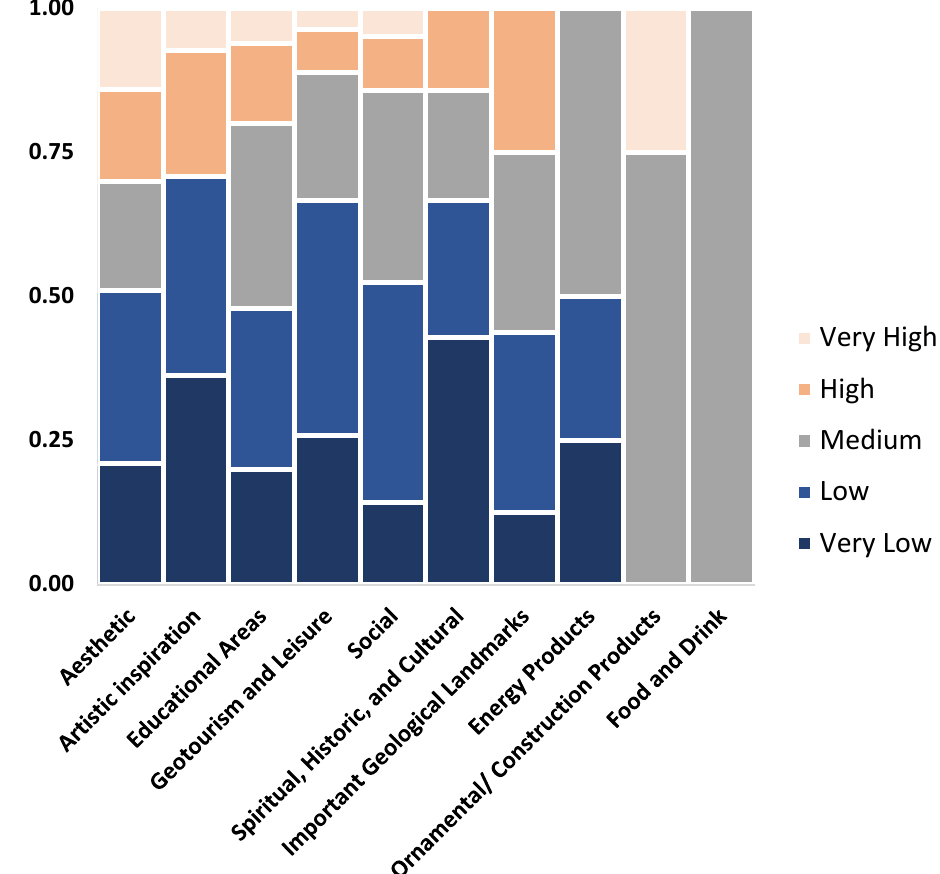
Figure 5. Stacked column graph depicting the proportion of each geodiversity category (very low to very high) contributing to the total response rate for individual geosystem services categories. The number of responses for each geosystem services category is listed in Table 4.